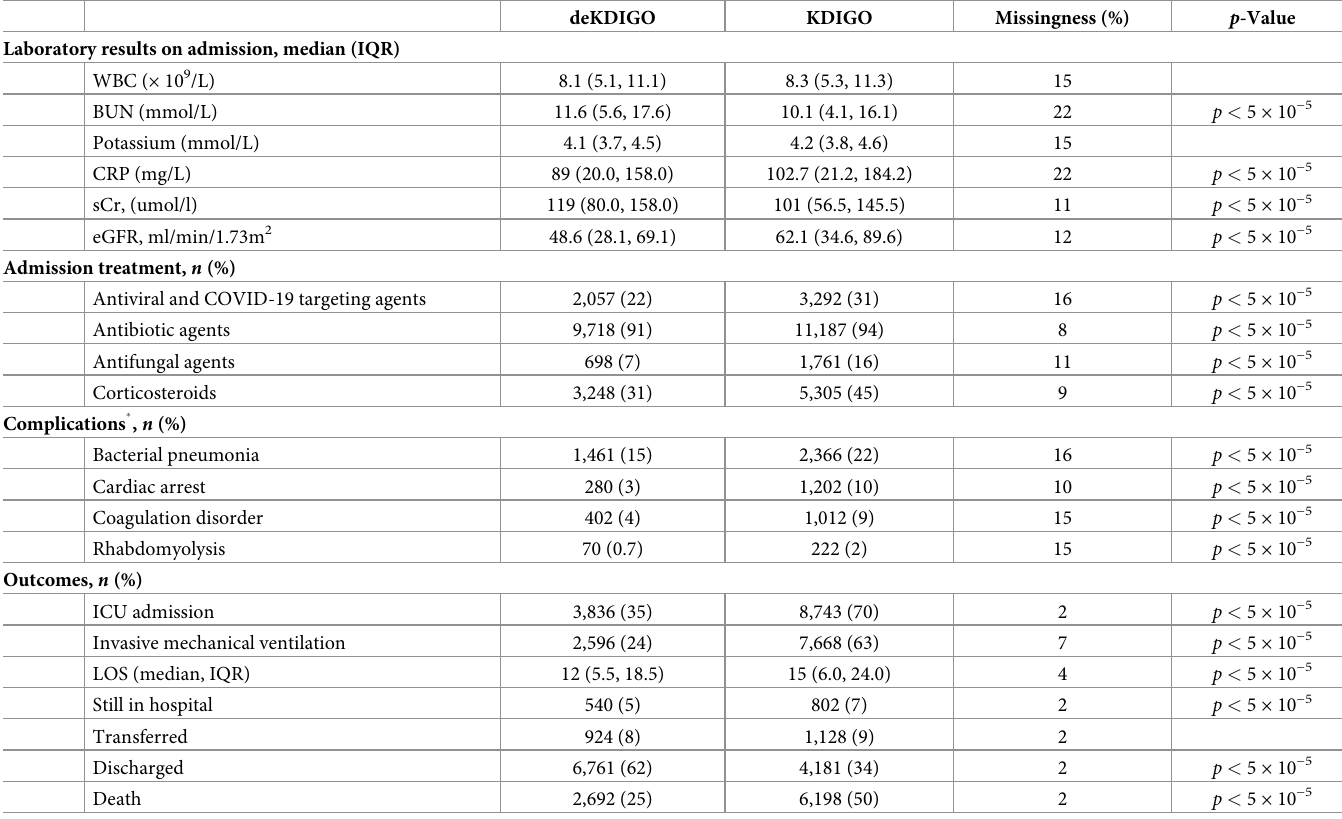
� Definitions of comorbidities, complications, and outcomes from the CRFs are presented in S2 Table. ACEi, angiotensin converting enzyme inhibitor; AKI, acute kidney injury; ARB, angiotensin II receptor blocker; BP, blood pressure; BPM, beats per minute; BUN, blood urea nitrogen; CKD, chronic kidney disease; COVID-19, Coronavirus Disease 2019; CRF, case report form; CRP, C-reactive protein; eGFR, estimated glomerular filtration rate (estimated using the CKD-EPI equation); eKDIGO, extended KDIGO; HIC, high income; ICU, intensive care unit; IQR, interquartile range; KDIGO, Kidney Disease Improving Global Outcomes; LLMIC, low and low middle-income countries; LOS, length of stay; NSAID, nonsteroidal anti-inflammatory drug; RRT, renal replacement therapy; sCr, serum creatinine; UMIC, upper middle income; WBC, white blood cell.